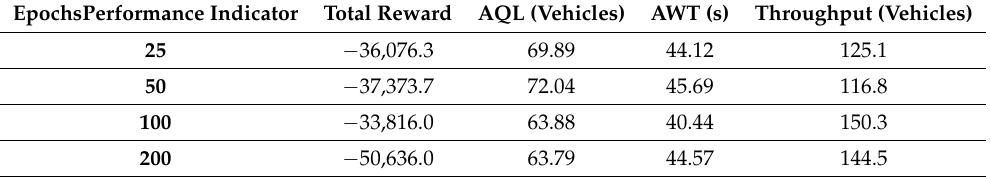
Figure 14. Performance results while training with three action time steps using 200 epochs. ( a ) AQL. ( b ) AWT. ( c ) Throughput. Table 7. Average performance of model trained with different number of epochs using action time step 0.2